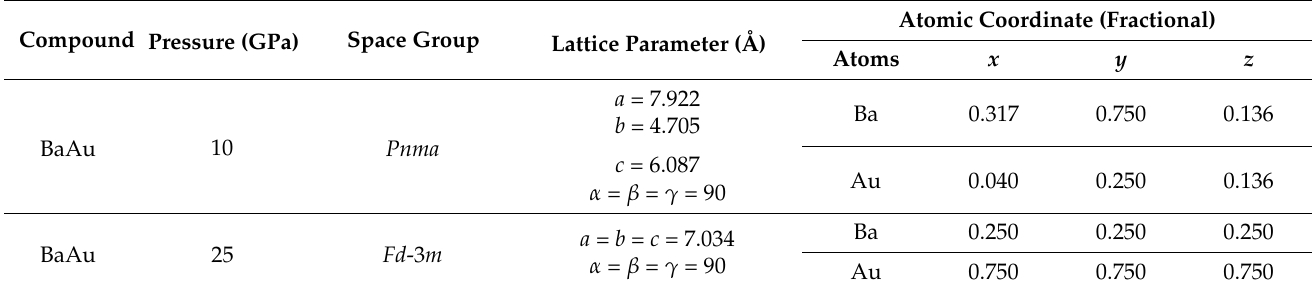
Table 1. Structural parameters of stable BaAu compounds under high pressure.